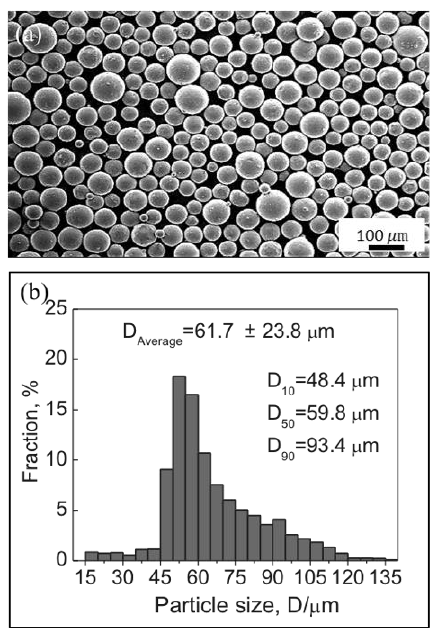
Figure 2. ( a ) SEM image and ( b ) powder size distribution of Ti64 powder supplied by Arcam AB.